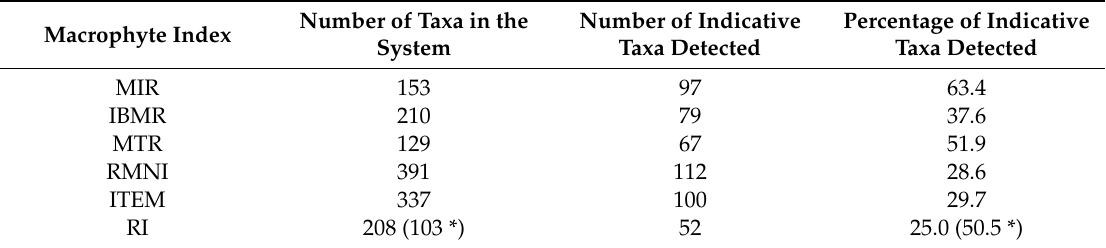
Table 4. The number of indicator taxa used by various macrophyte systems and species recorded in the surveyed